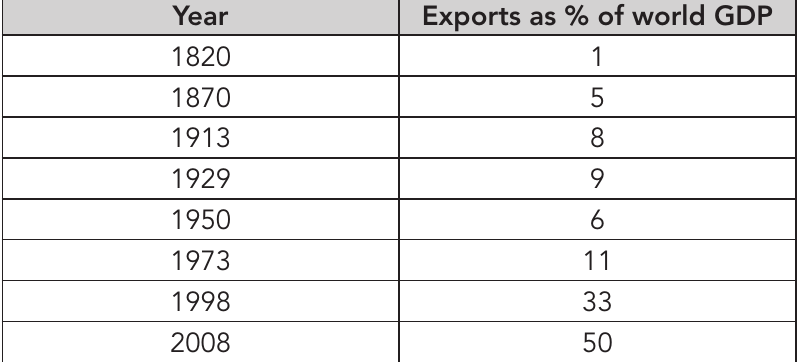
Table 1: Global exports as percentage of GDP (1820 to 1973 from Oosterhaven & Rietveld, 2005: 35; 1998 and 2008 from Trading Economics,